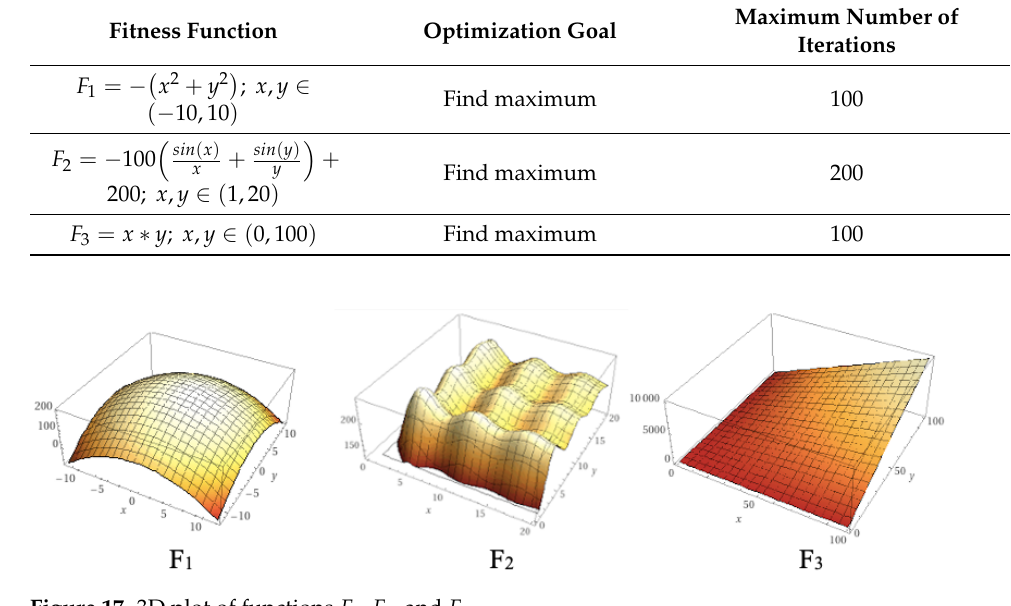
Figure 17. 3D plot of functions F 1 , F 2 , and F 3 .